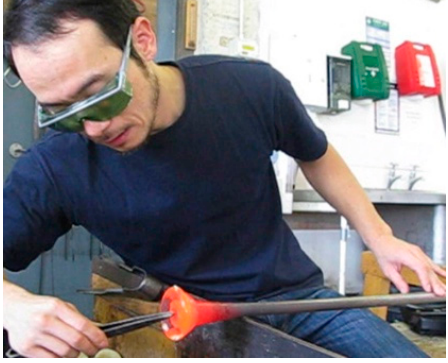
Figure 10. Preparing the collar.